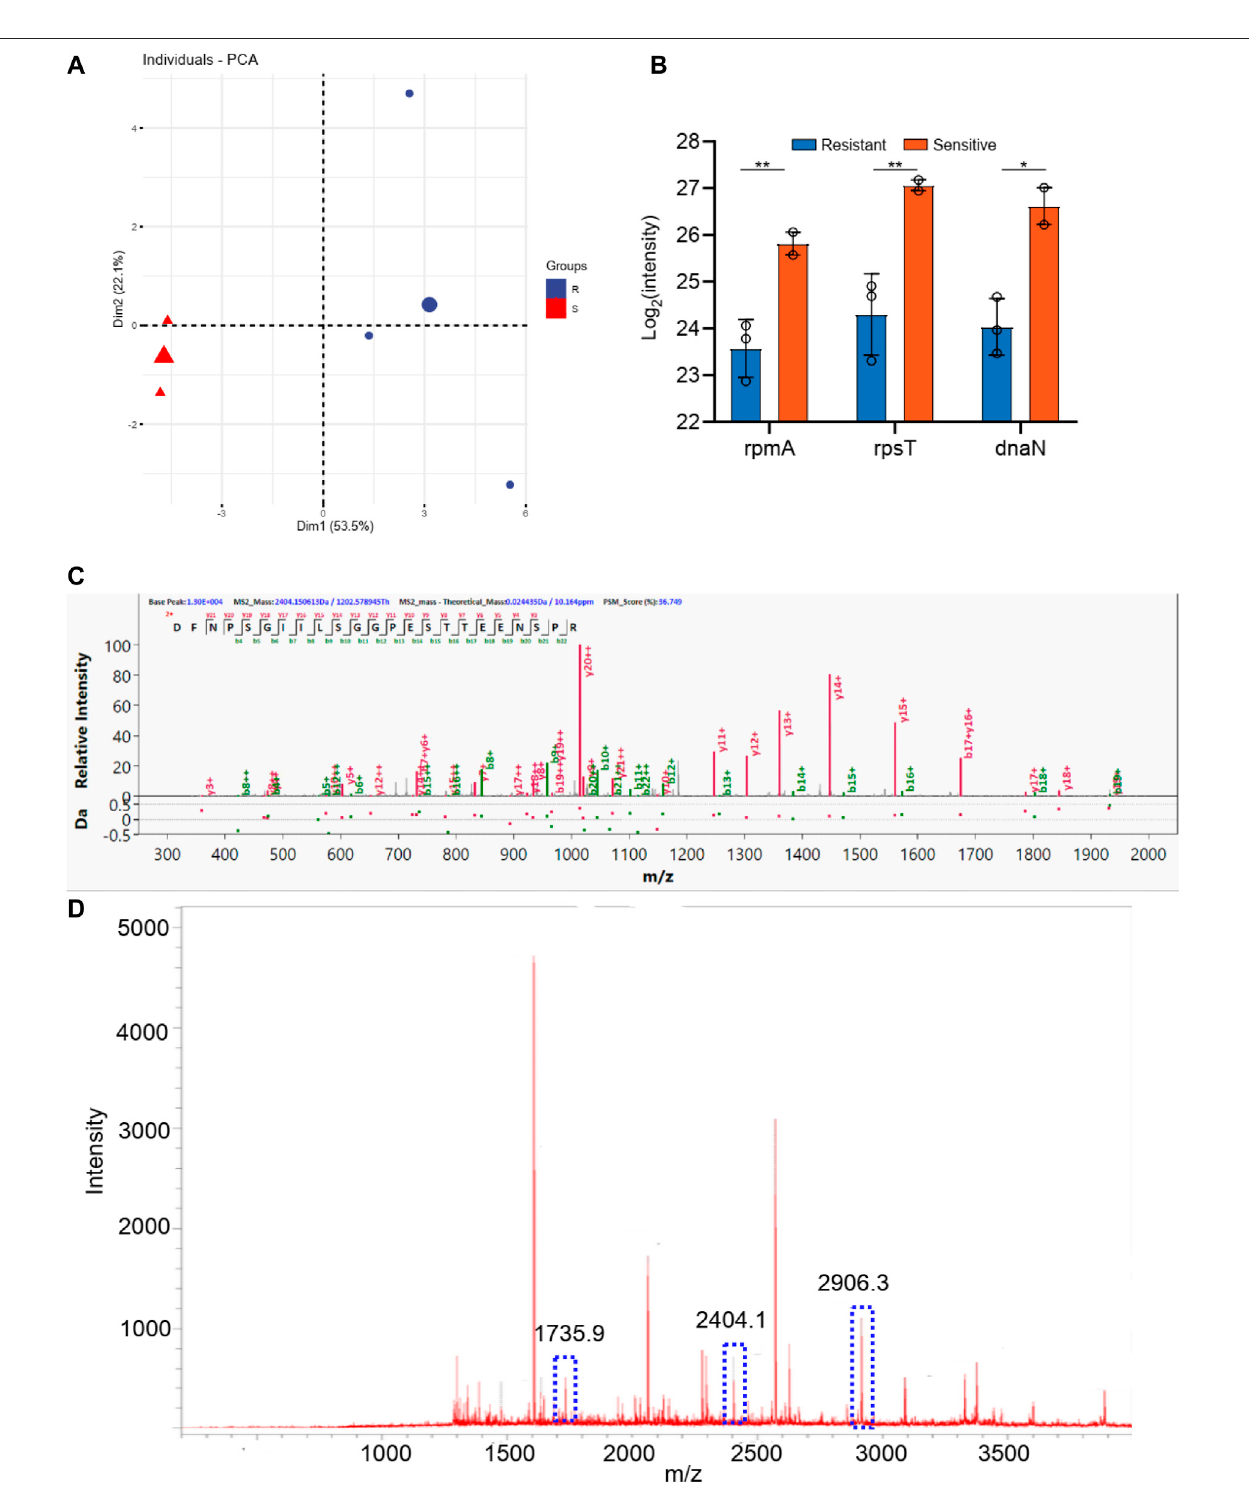
FIGURE 6 | (A) The PCA analysis of drug resistance of tetracycline for Staphylococcus aureus ; (B) The differential proteins between drug resistance group and drug sensitive group; (C) The corresponding differential peptides and (D) the fi nger print in MALDI TOF.